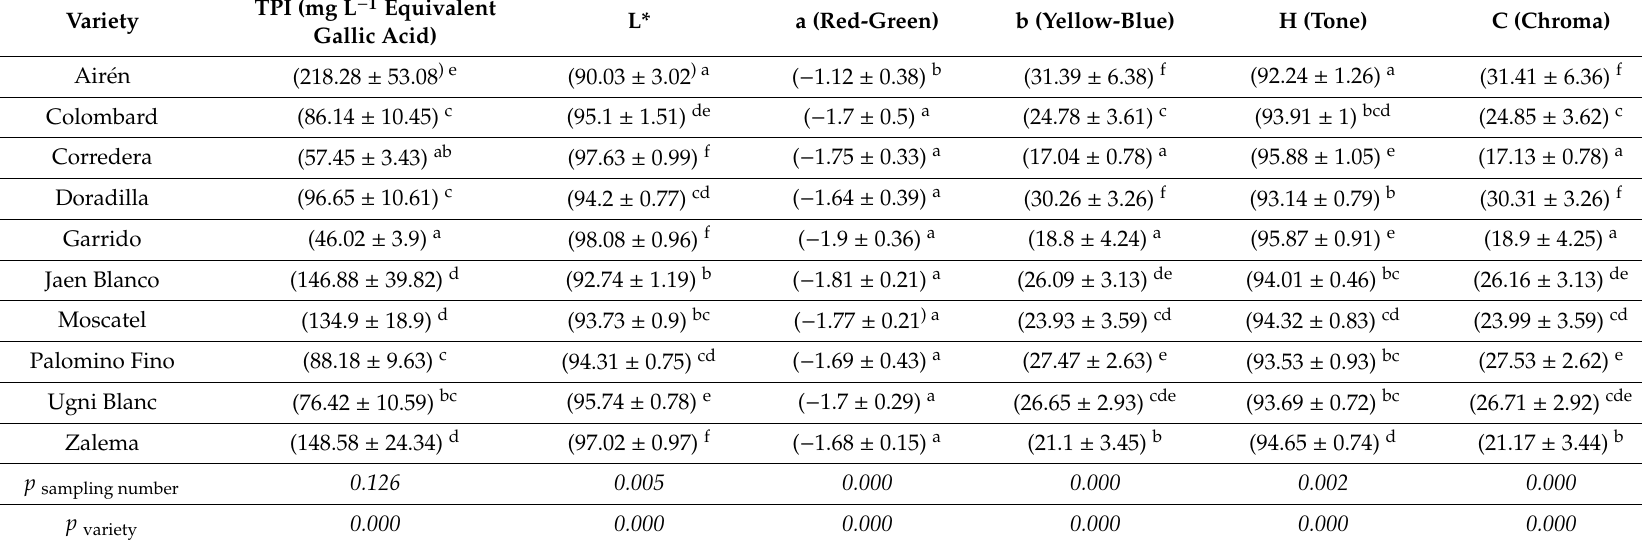
Table 2. Results of the two-way analysis of variance applied to IPT and chromatic parameters. Values are expressed as average ± standard deviation according to the variety factor. For each variable, identical superscripts indicate that there is no di ff erence between the values for those varieties. L*: brightness of color and TPI: total polyphenol